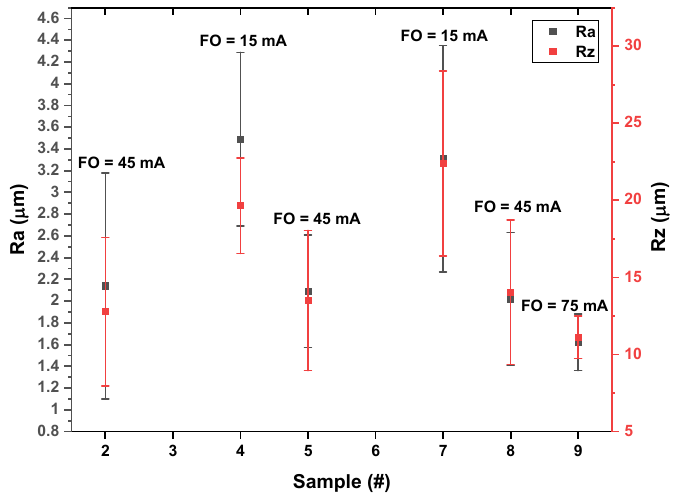
Figure 4. Average surface roughness for each sample set and the focus offset (FO) used. The mechanical properties, yield strength (YS), ultimate tensile strength (UTS), and elongation at break (e f ) are shown in Table 4 and are plotted graphically, as can be seen in Figure 5. Figure 5 conveniently highlights the narrow scattering obtained for the strength of each samples sets, indicative of the process repeatability. In terms of elongation, the variance is slightly larger but still within reasonable limits. It can be seen that the lowest YS, UTS, and e f values measured are from the sample sets 3 and 6, similar to the density results obtained. On the other hand, the highest YS and UTS obtained are from sample sets 2, 8, and 9, and the sample set that presented the highest e f is 9. From comparing the correlated with the highest density. While density is a parameter that has a critical effect on the material’s properties (i.e., samples 3 and 6 where the density and the resulting strength are low), the effect does not extend to sets where the density was high (above 99.6%), and the differences were relatively small (~0.2%).